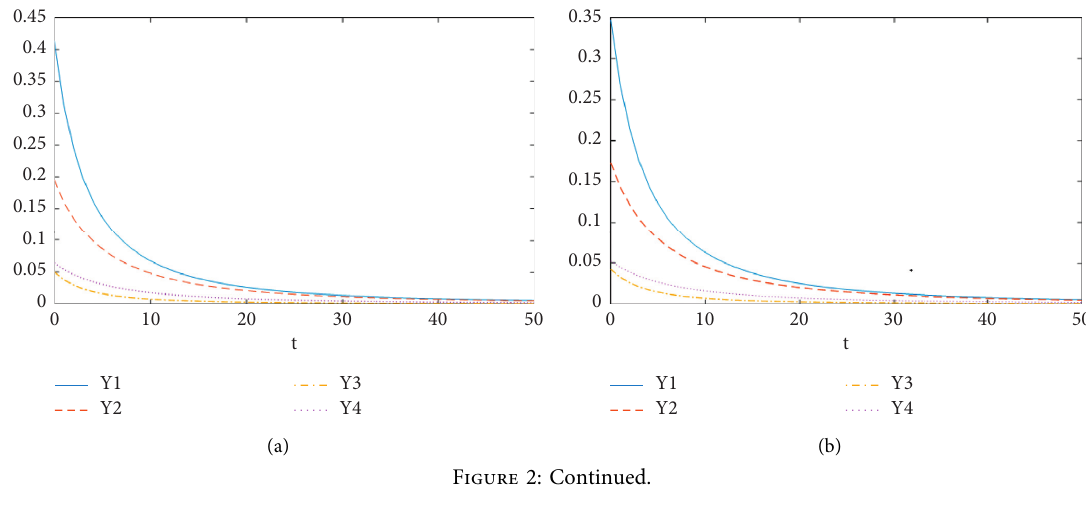
� 4 . 3, s � 5 . 0). (a) β � 0 . 2. (b) β � 0 . 4. (c) β � 0 . 6. (d) β � 0 . A B